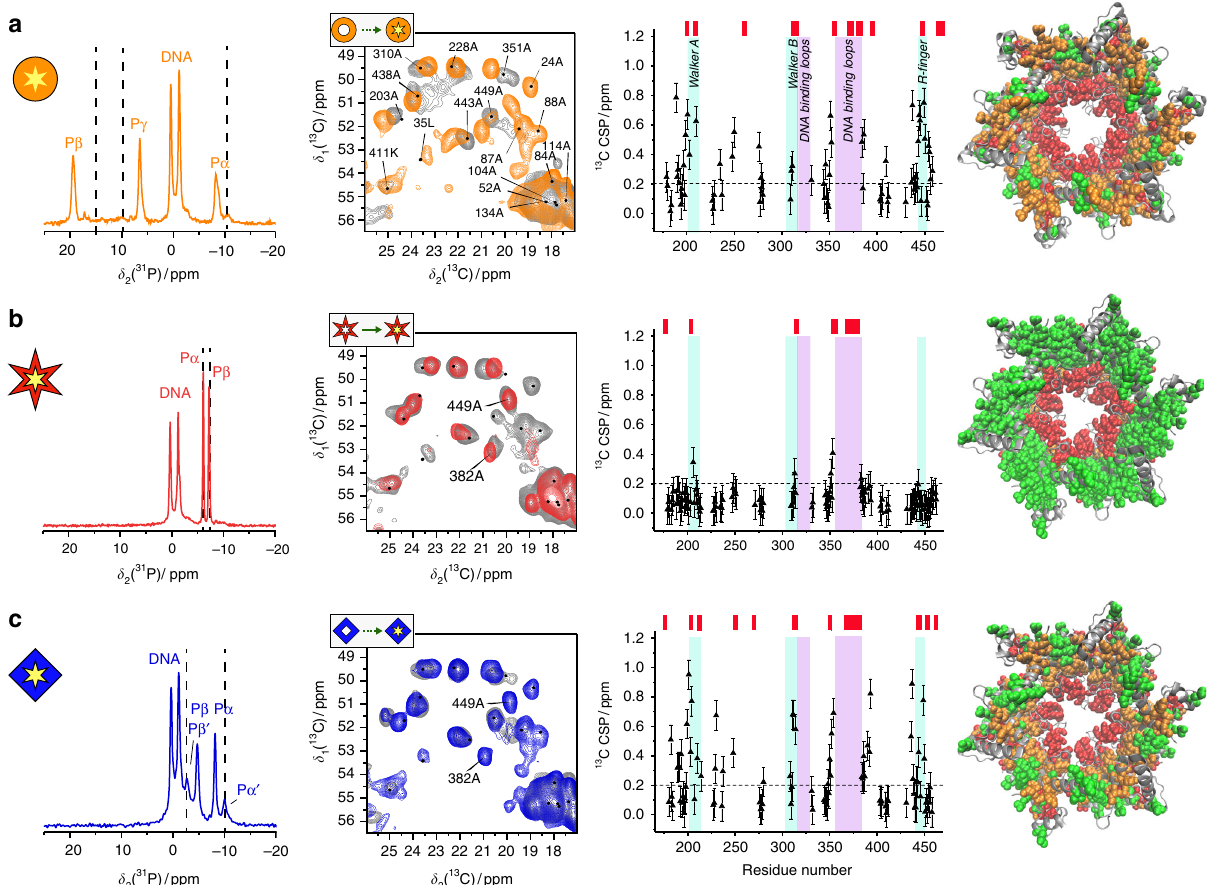
Fig. 3 The DNA-binding process: ADP:AlF 4 − preorganizes DnaB for DNA binding. 31 P spectra (left column) of the ssDNA bound states of a AMP-PCP, b ADP:AlF 4 − , and c ADP. The dashed lines represent the 31 P chemical-shift values in the absence of DNA, see also Fig. 2. Second column: 13 C- 13 C DARR correlation spectra with (coloured) and without (grey) ssDNA. Third column: 13 C C α -C β CSPs upon ssDNA binding. The error bars (identical for all residues) are estimated to 0.1 ppm from the differences in the experimental spectra. Residues highlighted in red on top of the CSP plot highlight resonances appearing in the NMR spectra upon DNA binding. The last column shows a plot of the 13 C CSPs on a structural model based on pdb code 4ZC0 (residues 174 – 488 are shown) (green: CSP < 0.2 ppm, orange: CSP ≥ 0.2 ppm, red: newly appearing in the spectrum upon DNA binding, grey: unassigned). All source data for the chemical-shift values of columns 1 and 3 are listed in the Source Data fi